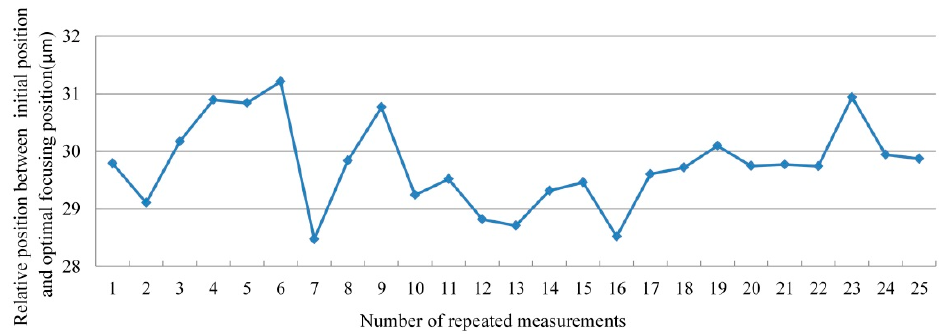
Figure. 9. Distance between initial and optimal focusing positions.